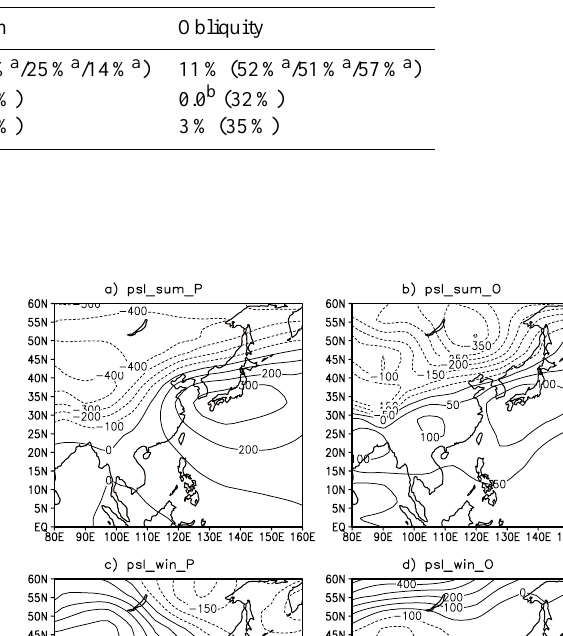
Table 1. Variance percentages of astronomical components for both geological climatic proxies and model simulated indices of East Asian summer and winter monsoons (precession component: 18–25ka bandpass-filtered; obliquity component: 33–50ka bandpass-filtered). The grain size data from Jingyuan (J)/Xifeng-Changwu (X)/Zhaojiachuan (Z) sections are respectively shown for winter monsoon. The referenced